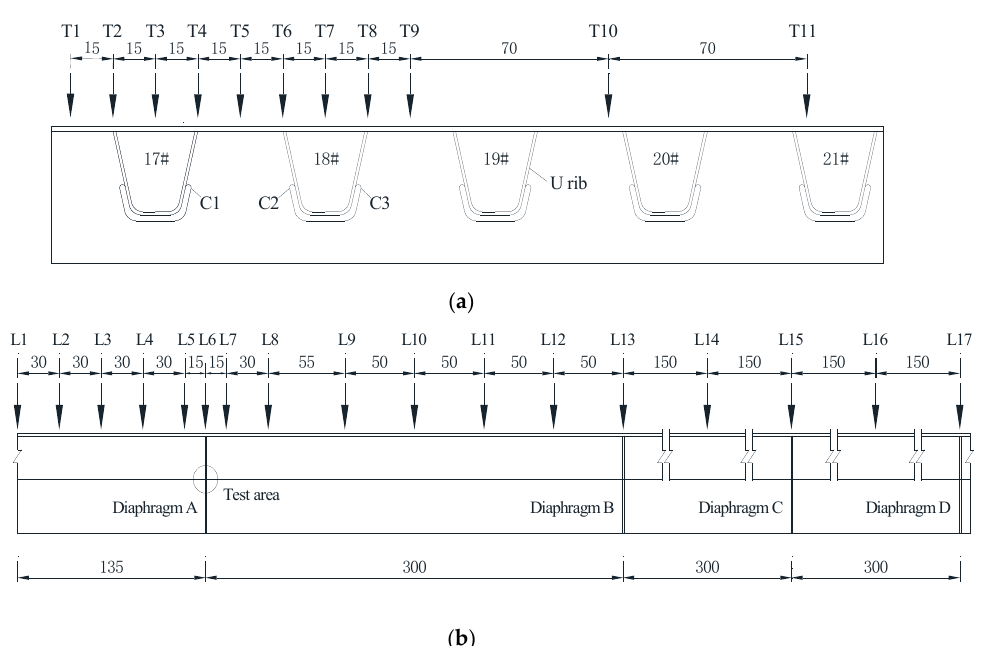
Figure 13. Methods to locate wheel loads.